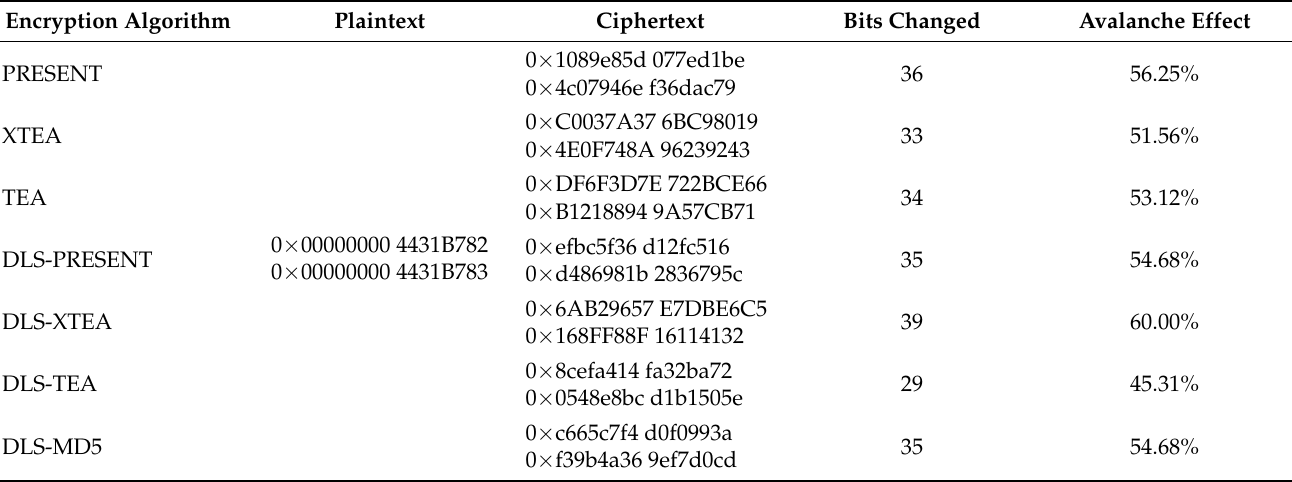
Table 2. Avalanche effect calculated when a one-bit change is made on a specific plaintext.